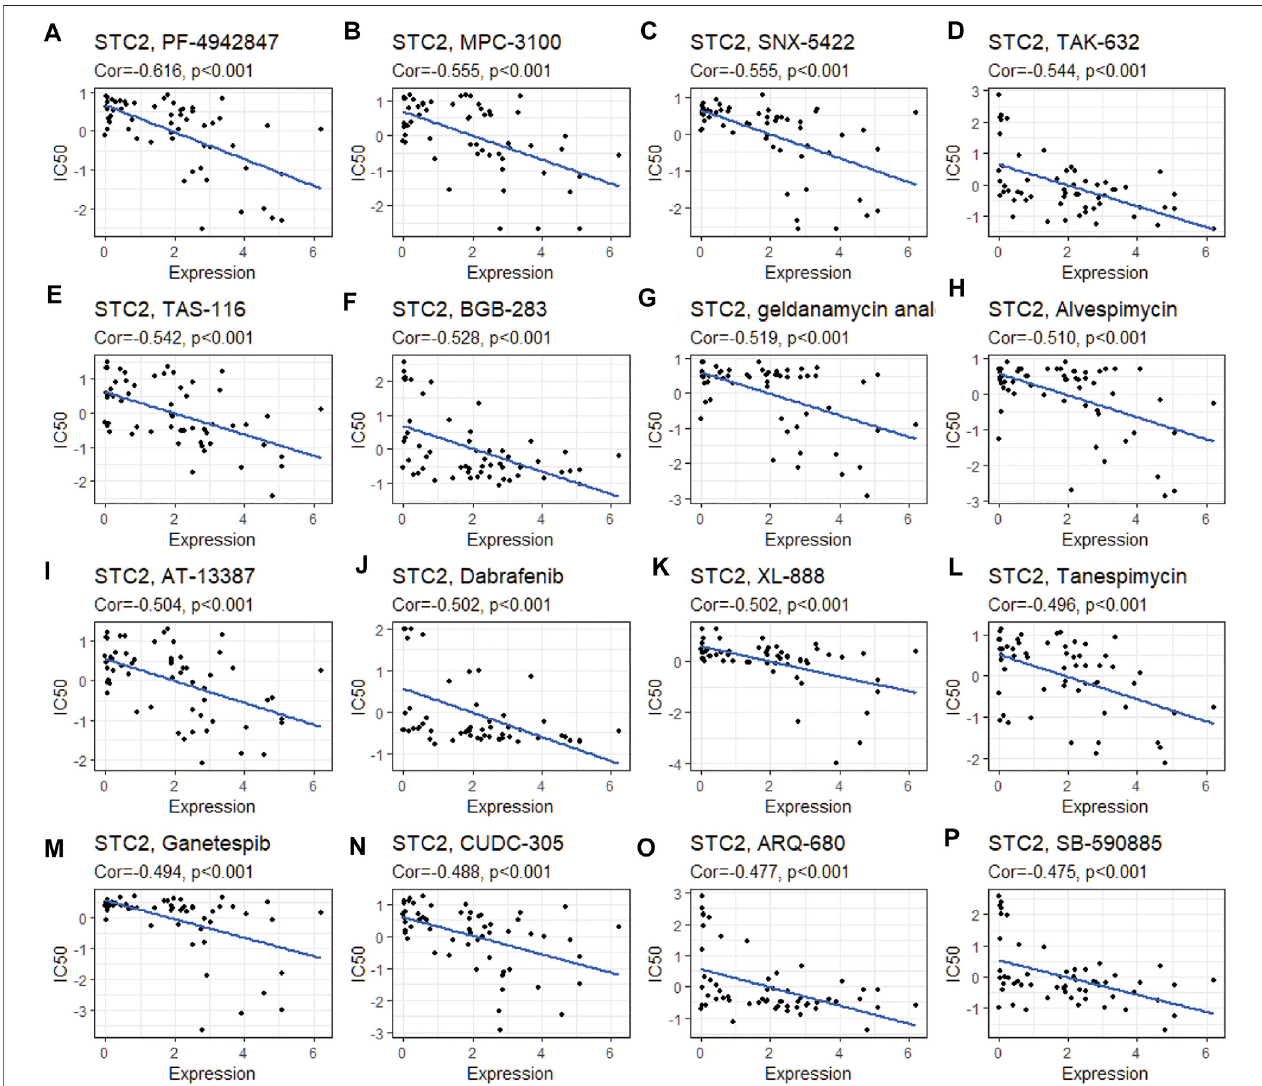
FIGURE9| Drug sensitivity analysisofSTC2.The expression ofSTC2 was associated withthedrugsensitivityofPF-4942847 (A) ,MPC-3100 (B) ,SNX-5422 (C) , TAK-632 (D) , TAS-116 (E) , BGB-283 (F) , geldanamycin analog (G) , alvespimycin (H) , AT-13387 (I) , dabrafenib (J) , XL-888 (K) , tanespimycin (L) , ganetespib (M) , CUDC-305 (N) , ARQ-680 (O) , and SB-590885 (P) .